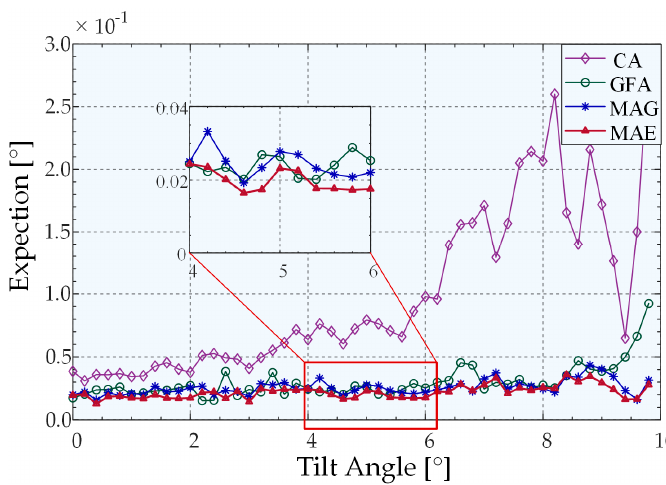
Figure 13. Angular prediction errors of different algorithms.